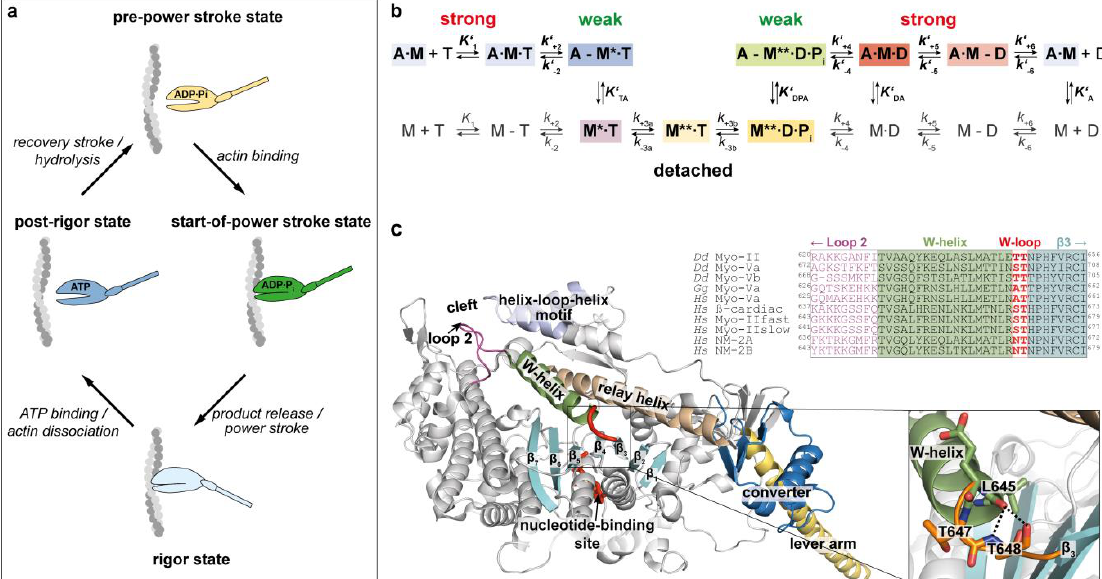
Figure 1. The actomyosin ATPase cycle and structural features of the myosin motor domain. ( a ) The Lymn–Taylor four-state model and the predominant equilibrium states of the actomyosin cycle. Rigor state: strongly actin-bound state (lever arm in “down” position). Post-rigor state: actin-detached state with bound ATP (actin-binding cleft “open”). Pre-power-stroke state—weakly actin-bound state; conformational state after the recovery step with hydrolyzed ATP; lever arm in “up” position. Start-of-power-stroke state: myosin re-associates with actin (binding triggers product release and initiates the power stroke). ( b ) Kinetic scheme of the actomyosin ATPase reaction. Colored states illustrate nucleotide-associated conformational transitions of myosin. A: actin; M: myosin; M*, M**: fluorescence sensitive states of myosin; T: ATP; D: ADP; P i : phosphate. Strong nucleotide and actomyosin interactions are indicated with a dot, weak interactions with a hyphen. Equilibrium constants and rate constants depending on actin are given with a prime in bold italic (e.g., K’ 1 , k’ +1 ), all others in italic font style (e.g., K’ 1 , k’ +1 ). Equilibrium constants indexed with T, D, P, and A represent the affinity of the respective nucleotide state of myosin for actin (e.g., K’ DPA ). ( c ) Structural elements and domains in the myosin-2 motor involved in coupling actin binding to force generation. X-ray crystal structure of the D. discoideum myosin-2 motor domain (PDB: 1g8x) highlighting the W-loop in red as connecting element of the W-helix (green) and the transducer (cyan) and close-up view of the W-helix/transducer region showing amino acids T 647 and T 648 in the W-loop interacting with surrounding residues (inset). The W-helix interacts with β-sheets strands 3 to 7 (cyan), the relay helix (orange), the helix-loop-helix motif (blue) and the two connector sequences, the strut (yellow) and loop 2 (magenta). Multiple sequence alignment of the W-helix/transducer region for different myosin isoforms highlights the conservation of the W-loop throughout myosin classes.